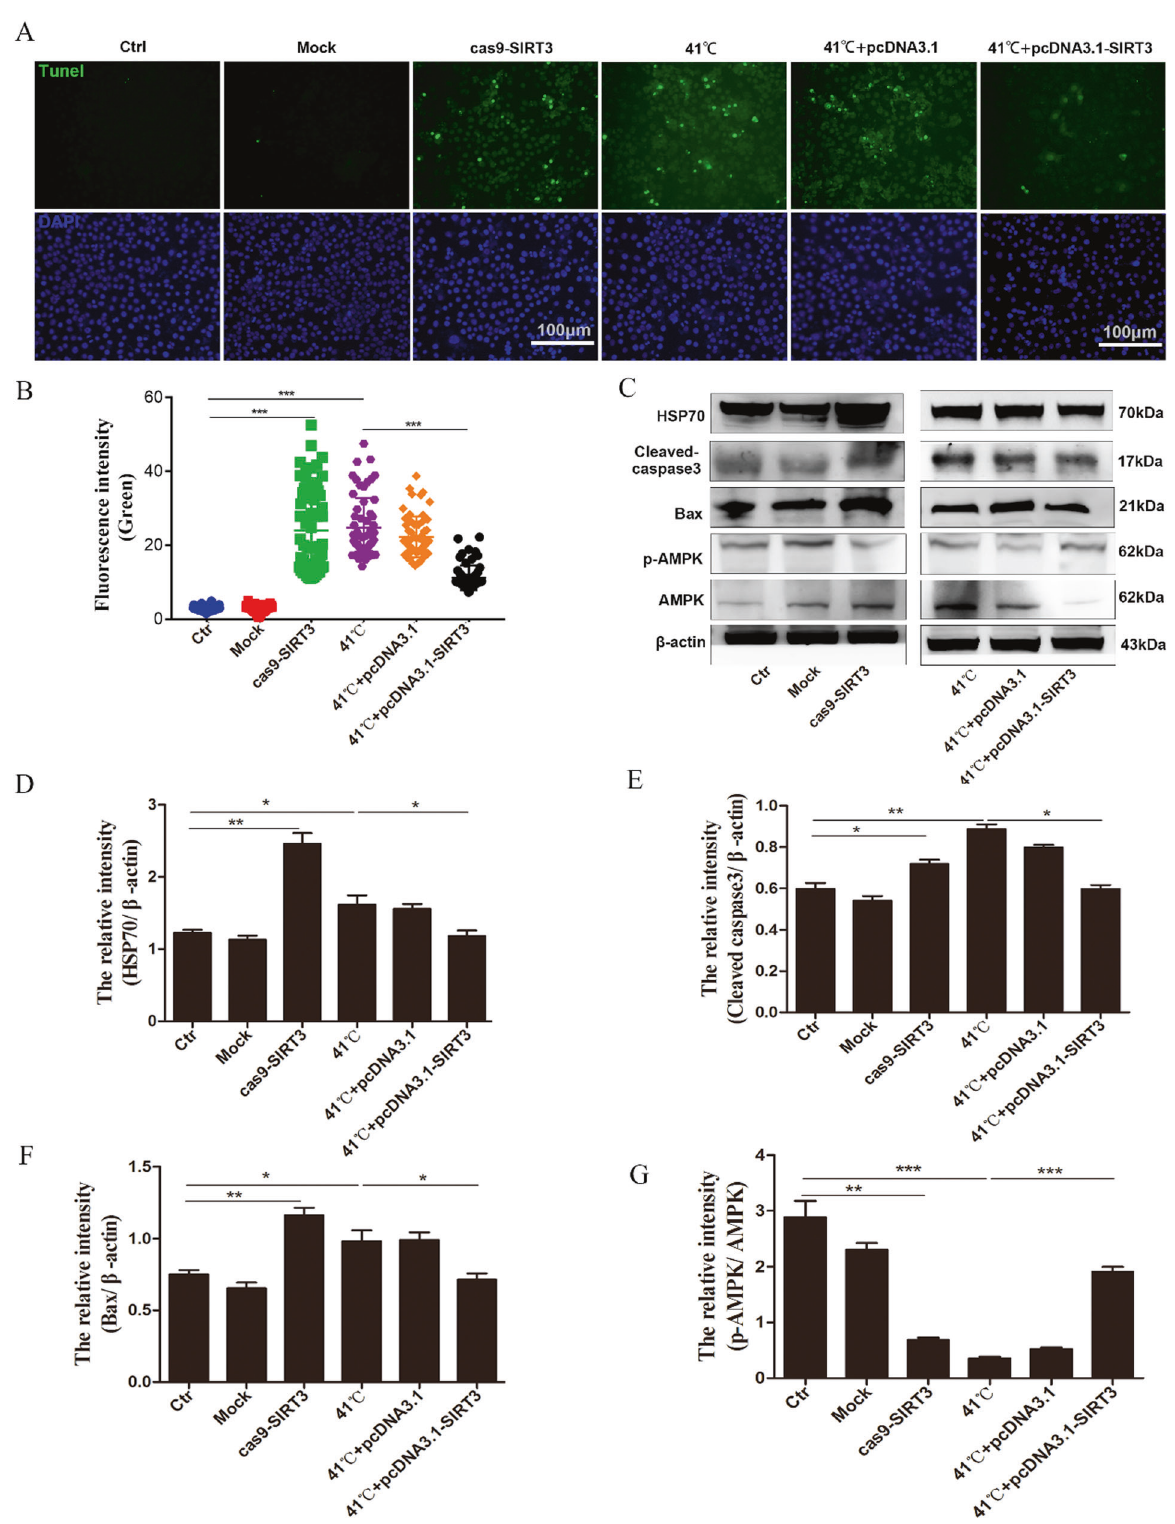
Fig. 4 SIRT3 attenuates BMEC apoptosis induced by heat stress. A TUNEL staining was used to determine cell apoptosis. Green, TUNEL; blue: DNA; Scale bar: 100 µm. B The percentage of apoptotic cells was quanti fi ed by counting green positive cells. C The protein levels of HSP70, cleaved-caspase 3, Bax, p-AMPK, and AMPK were determined by western blotting. D – G The quanti fi cation of the relative protein levels is shown under the band (protein/ β -actin). Data are expressed as mean ± SEM ( n = 3), * P < 0.05; ** P < 0.01; *** P < 0.001.